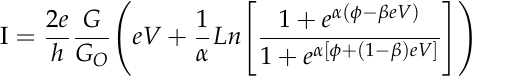
Figure 3. XPS depth profile analysis of Al 2 O 3 layers deposited using TALD process at 300 °C.